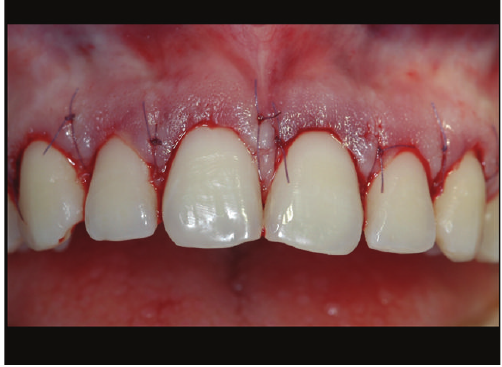
Figure 9: Soft tissue healing 6 months after surgery.